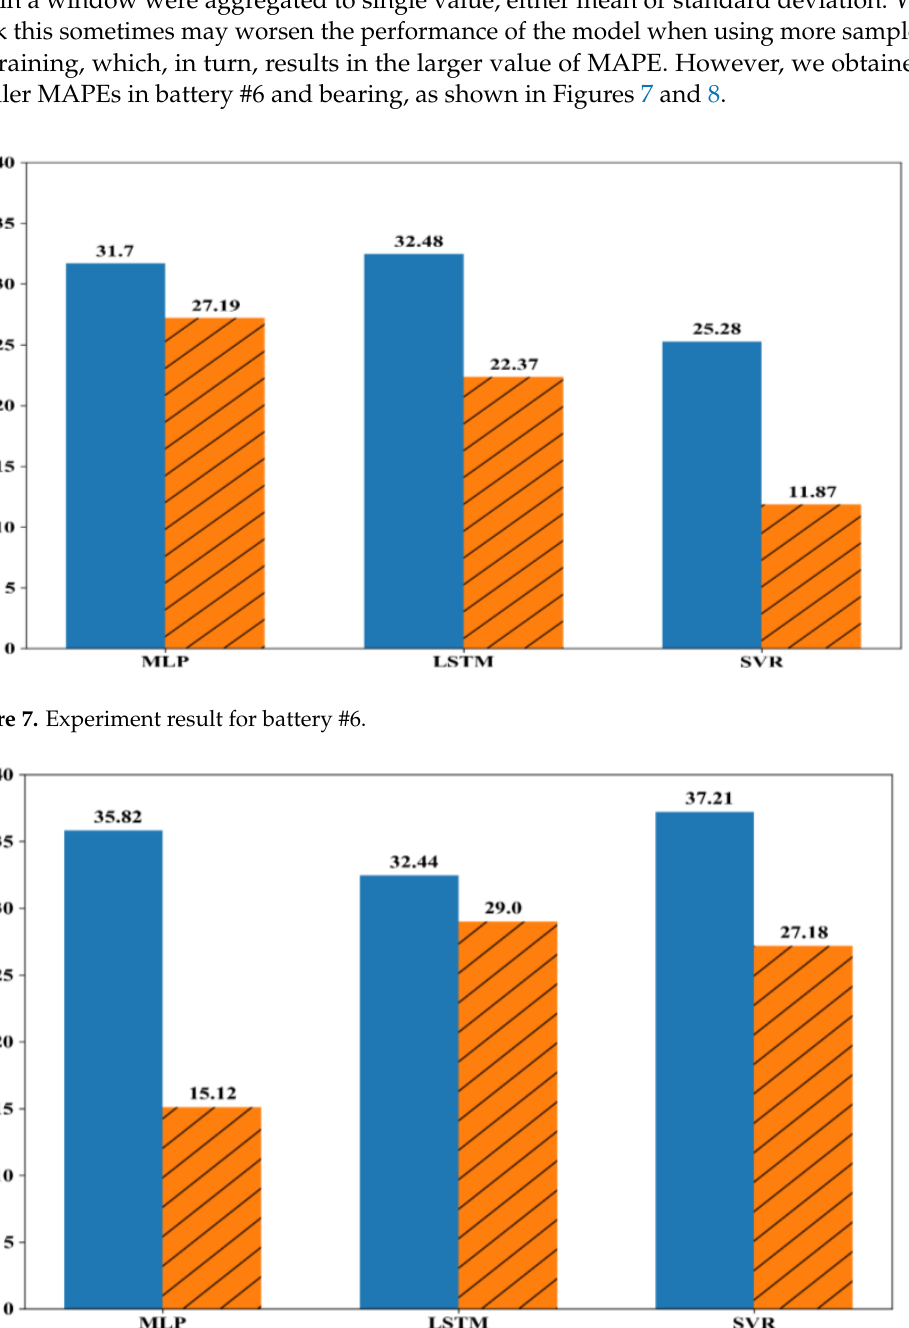
Figure 8. Experiment result for bearing.